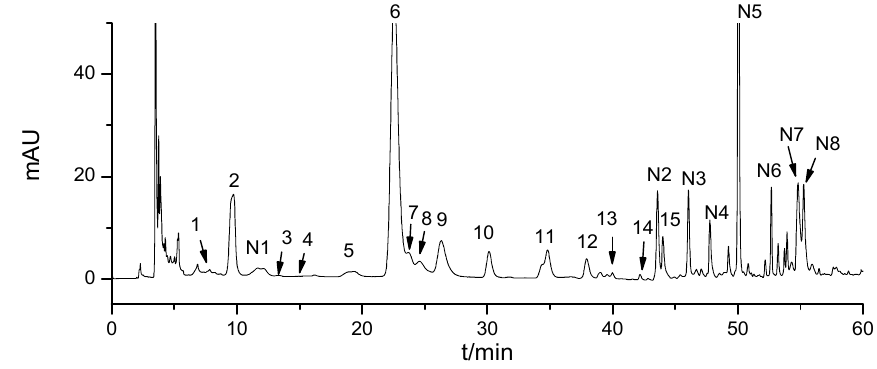
Figure 1. HILIC-DAD chromatograms of Cordyceps extract ( 1 ) Thymine; ( 2 ) Uracil; ( 3 )Thymidine; ( 4 ) 2'-Deoxyuridine; ( 5 ) Cordycepin; ( 6 ) Uridine; ( 7 ) Hypoxanthine; ( 8 ) Adenine; ( 9 ) Adenosine; ( 10 ) Xanthine; ( 11 ) Inosine; ( 12 ) Cytosine; ( 13 ) Guanine; ( 14 ) Cytidine; ( 15 ) Guanosine; (N1-N8: non-target